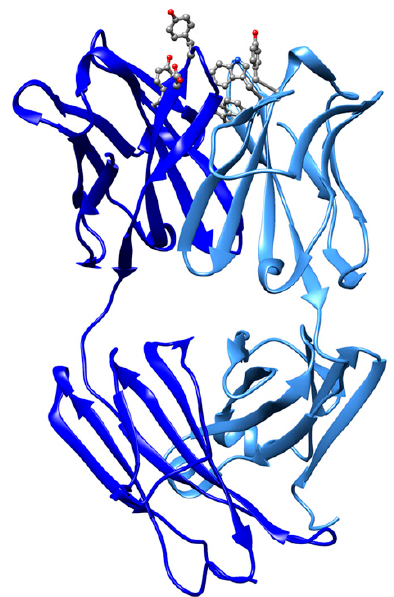
Figure 1. Ribbon drawing of mouse antifullerene antibody Fab-C 60 (pdb entry 6H3H). The structure of Fab-C 60 (complex of heavy (H) and light (L) chains) shows a fullerene binding pocket consisting of a canonical CDR region that contains various aromatic residues and an aspartate residue highlighted in balls-and-sticks (O red, N blue, C gray).